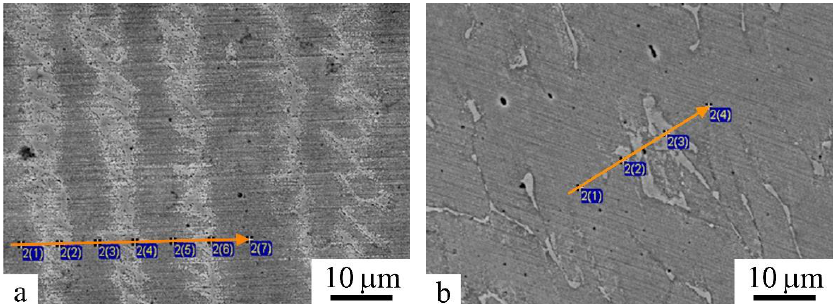
Figure 8. Microstructure of the deposited metal without ( a ) and with ( b ) layer-by-layer peening. SEM.